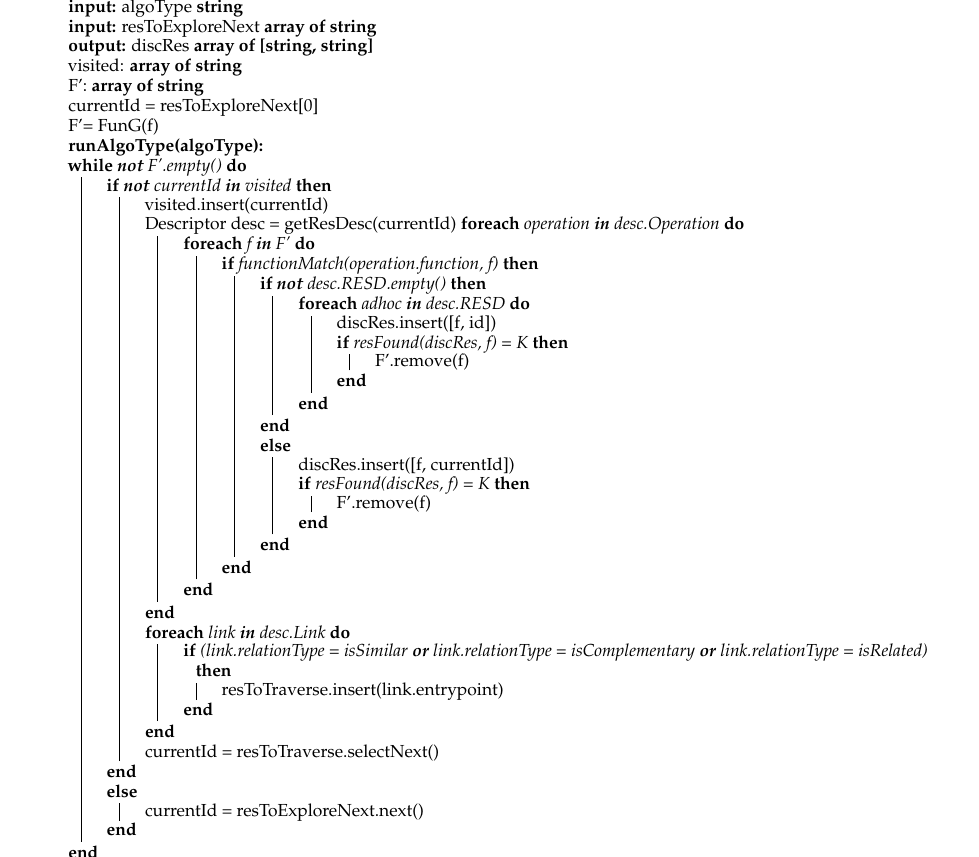
Algorithm A1: The Discover(agloType, resToExploreNext)